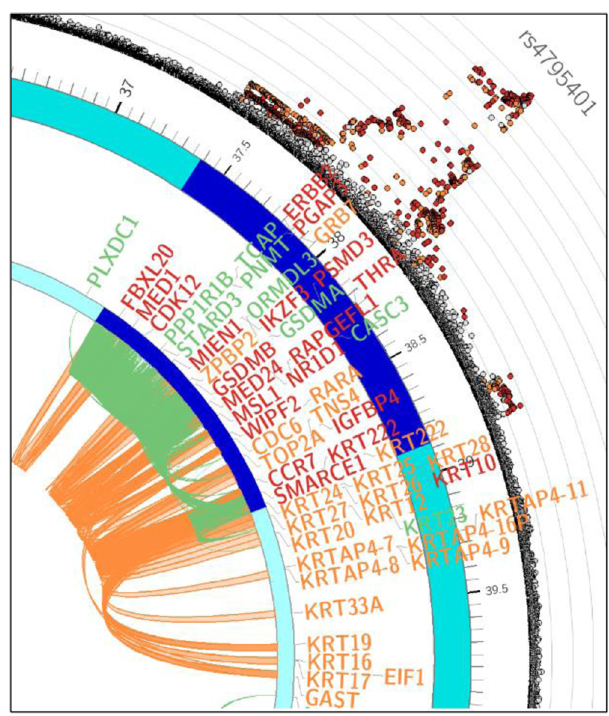
Fig. 6 Blood eQTLs and chromatin interactions in GM12878 at the 17q12- q21 asthma risk locus. The most signi fi cant asthma GWAS SNP is indicated at the most outer border of the circos plot. The subsequent layers show 1) genetic association results from the asthma GWAS in UK Biobank for SNPs with P value < 0.05 with the color of dots re fl ecting the level of LD with the sentinel variant (red: r 2 > 0.8, orange: r 2 > 0.6), 2) the chromosome coordinate and the asthma GWAS loci highlighted in dark blue, 3) blood eQTL genes, genes mapped by Hi-C, and genes mapped by both eQTL and Hi-C labeled in green, orange, and red, respectively, 4) green and orange lines link the position of eQTLs and chromatin interactions,